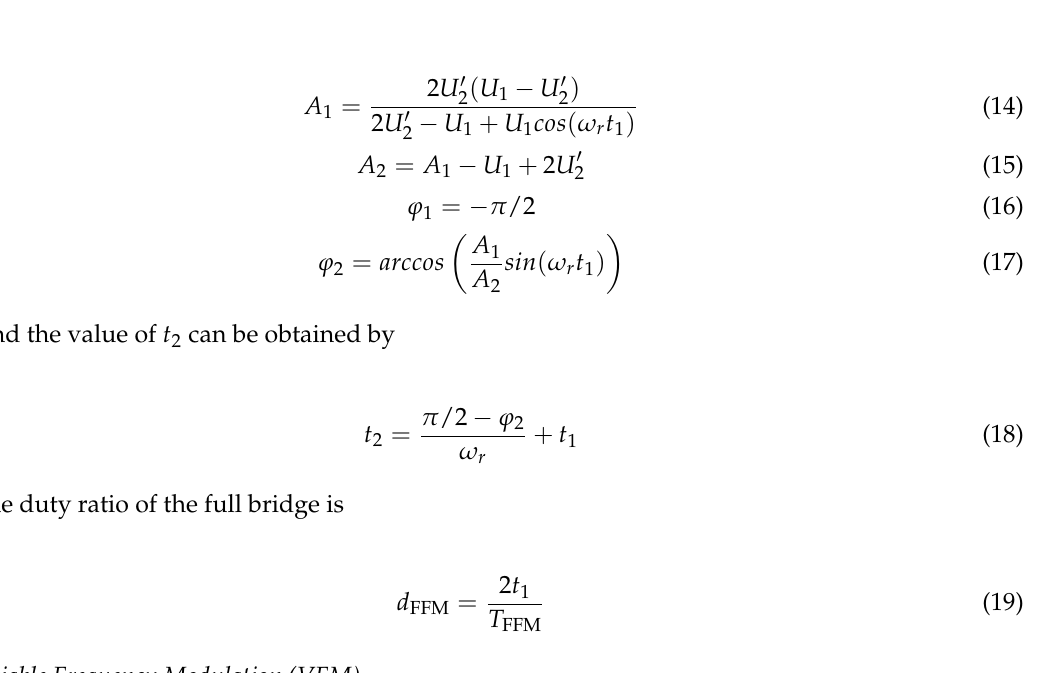
Figure 3. Operation stages of the proposed converter ( U 2 >